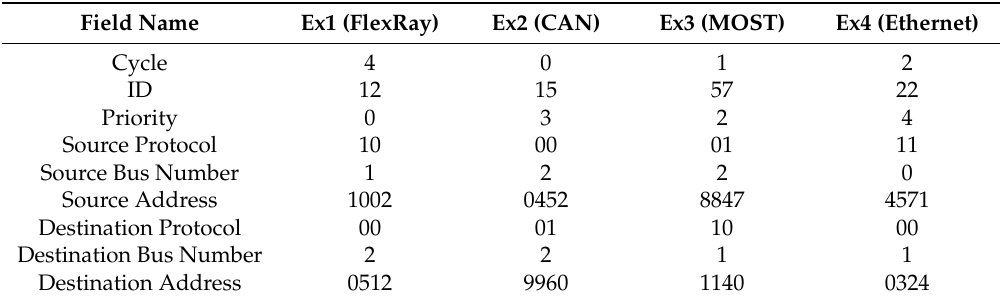
Table 1. The example of an Address Mapping Table.